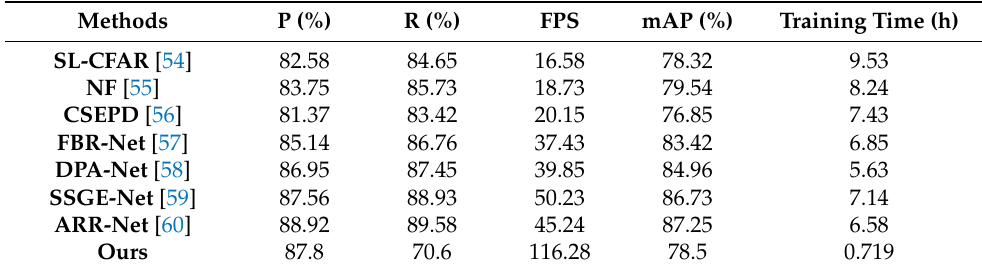
Table 7. Comparison between SAR ship detection methods on the AIR-SARship 1.0 dataset.